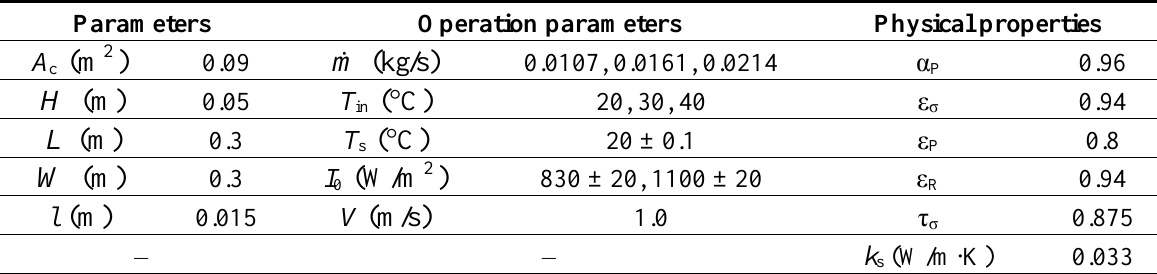
Table 1. Specifications of system properties, operating conditions and essential physical properties.